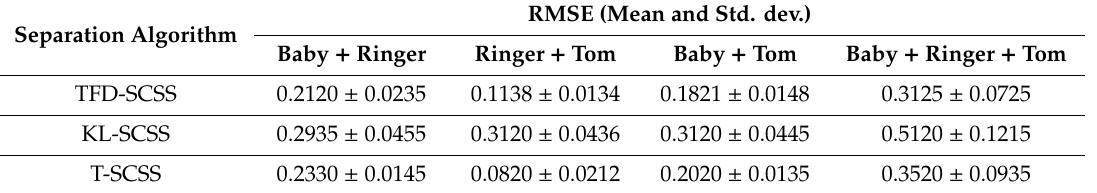
Table 3. RMSE index mean and standard deviation for separation algorithms used in comparative